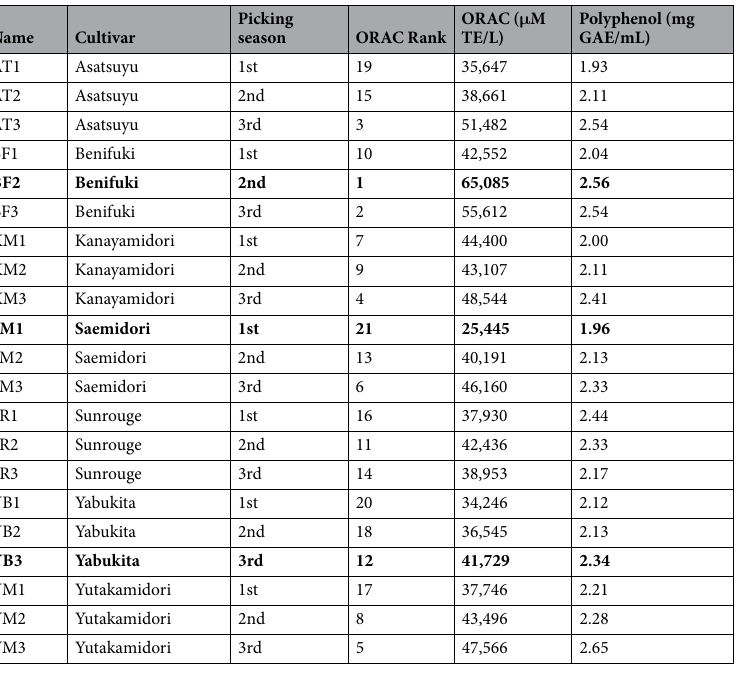
Table 1. Ranking of anti-oxidant activity of 21 GTEs, consisting of 7 distinct cultivars harvested at 3 different picking seasons. Bold letters indicate three representative GTEs, corresponding to the highest, the middle or the lowest rank of ORAC